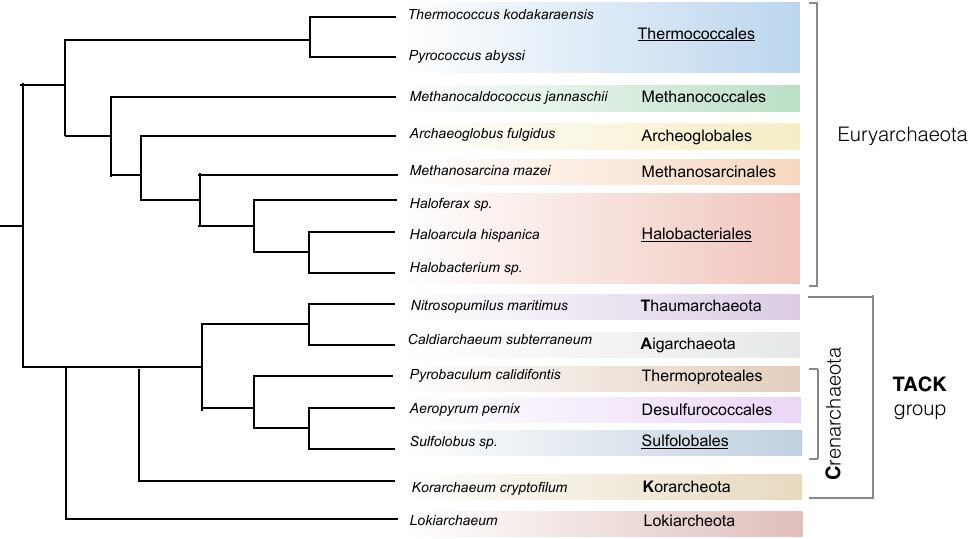
Figure 1. Current view of the archaeal phylogenetic tree. Based on [6,7]. The groups in which in vivo replication initiation studies have been undertaken are